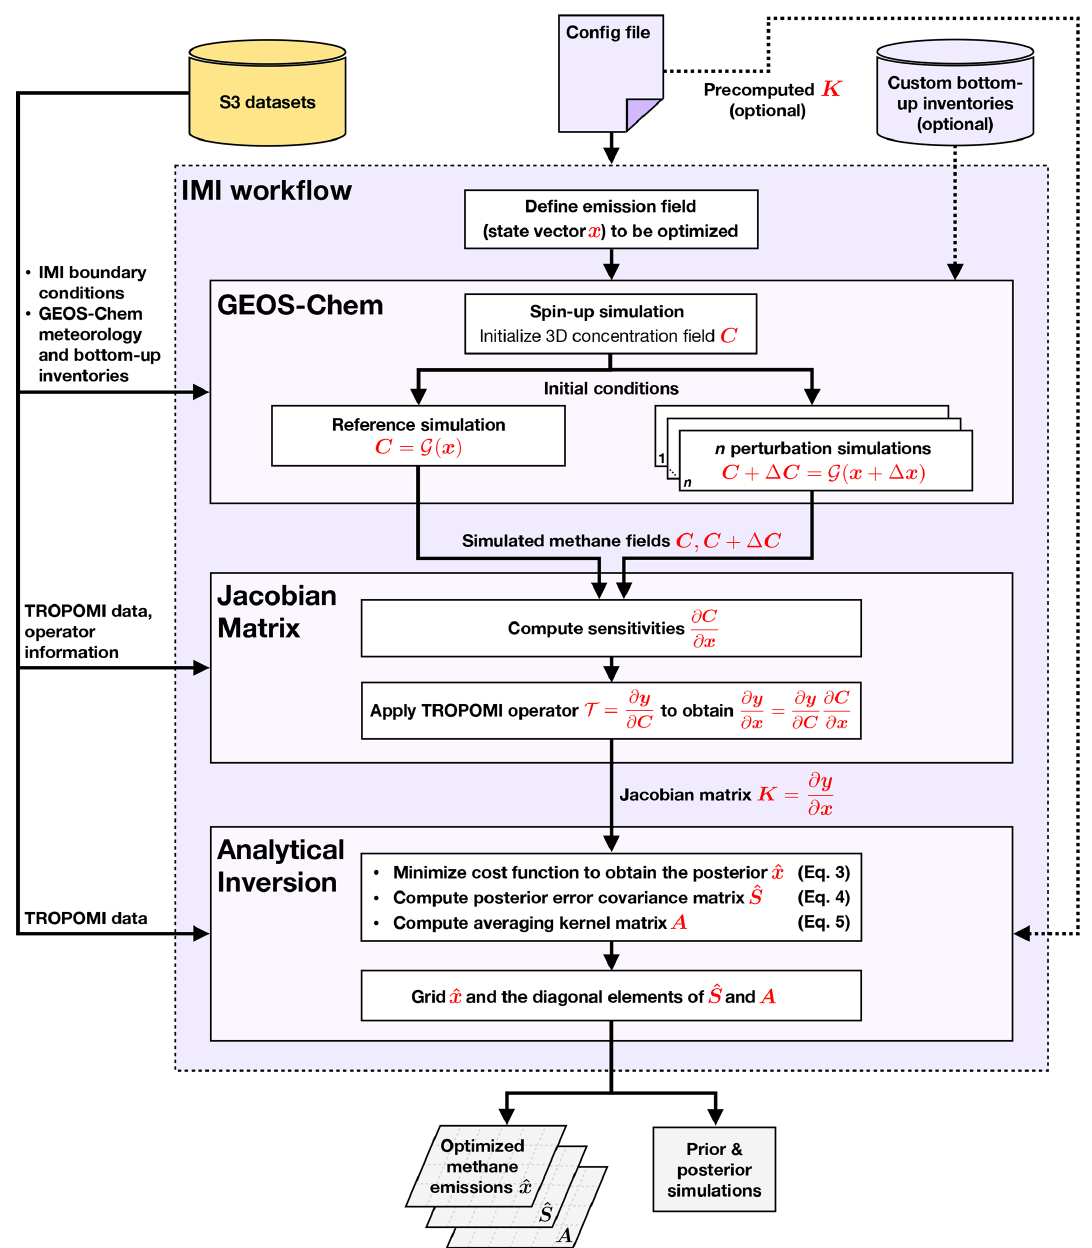
Figure 4. Flowchart for the Integrated Methane Inversion (IMI 1.0) on the AWS cloud. Here x is the emission state vector of length n , y is the vector of TROPOMI observations, C is the time-evolving 3-D GEOS-Chem methane concentration field over the inversion period, G is the GEOS-Chem operator, T is the TROPOMI operator, K is the Jacobian matrix, ˆ S is the posterior error covariance matrix, and A is the averaging kernel matrix. See Sect. 2 for equations and further description of the algorithm. The workflow has the option of skipping the calculation of the Jacobian matrix K if it has already been computed; this allows generation of a solution ensemble by varying inversion parameters (see text for